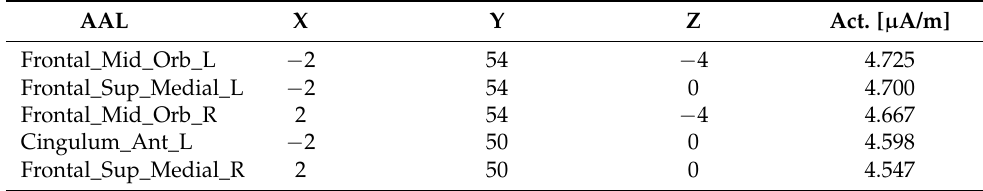
Table 4. Condition 3, with the same columns as Tables 2 and